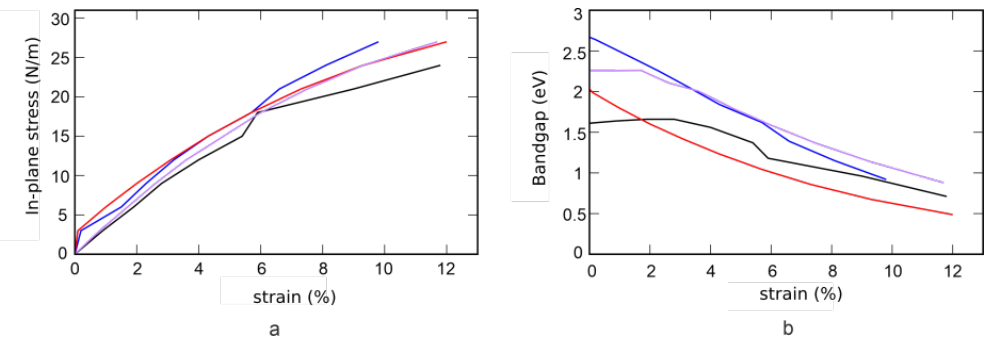
Figure 8. Dependences of stress ( a ) and band gap ( b ) on strain. SWSiN 2 (blue line), TeWSiN 2 (black line), SWGeN 2 (red line), and SeWSiN 2 (purple line).